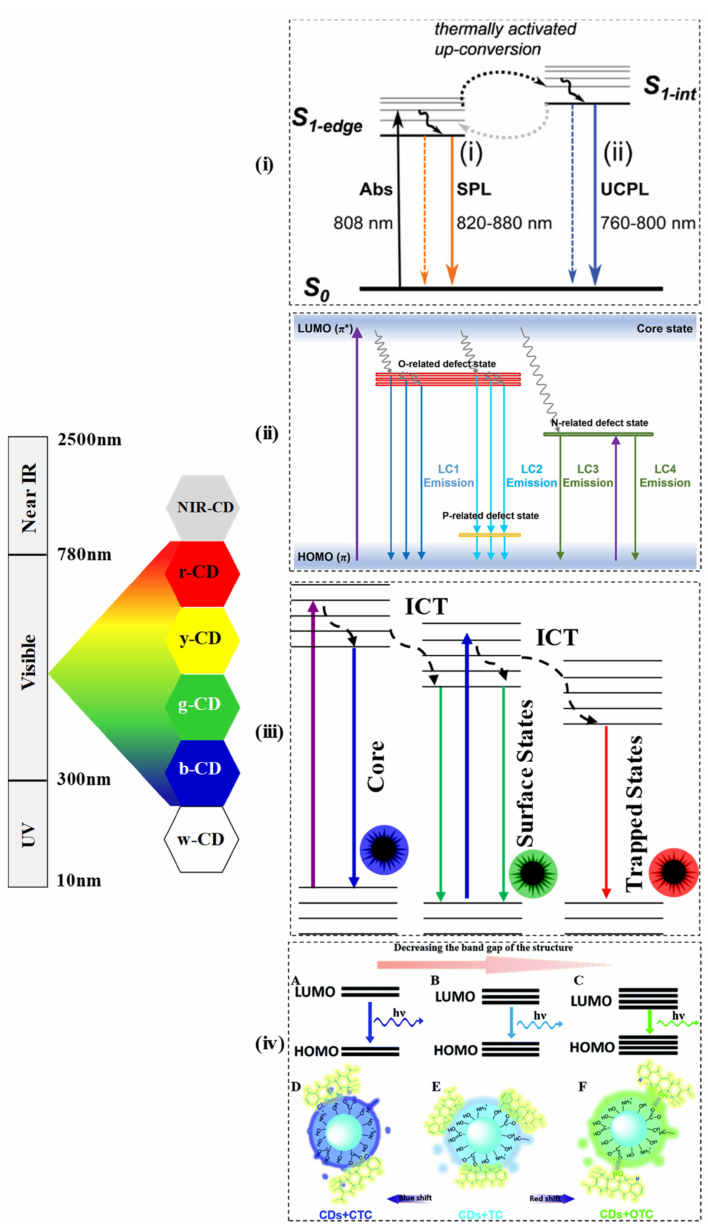
Figure 1. The band gap and transition of various colour exhibited by CDs (near infrared CD: NIR-CD, red-CD: r-CD, yellow CD: y-CD, green CD: g-CD, blue CD: b-CD, white CD: w-CD). ( i ) Proposed mechanism of up-conversion PL in Near IR (NIR) CDs [76] (Reproduced with permission), ( ii ) Proposed mechanism of CDs with O-defects, P-defects and N-defects states [24] (Reproduced with permission). ( iii ) Energy diagram of the CDs indicating the role of intersystem, charge transfer [41] (Reproduced with permission). ( iv ) Band gap transitions of CDs by introducing CTC, TC, and OTC [17] (Reproduced with